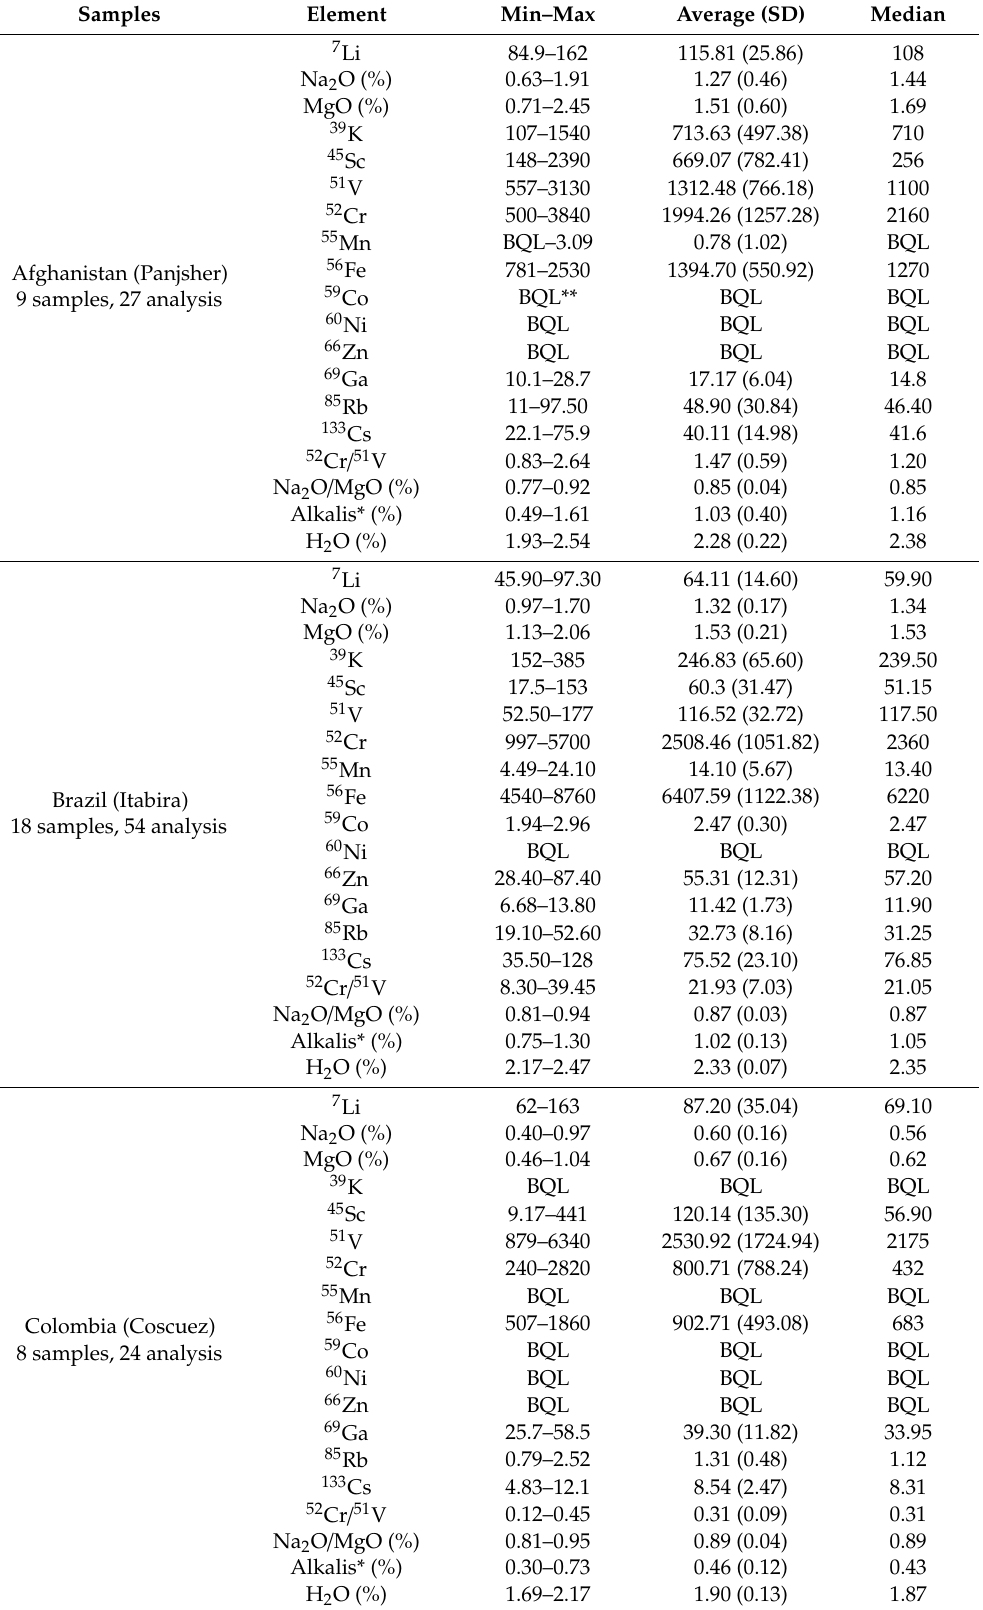
Table 3. LA–ICP-MS of the samples in